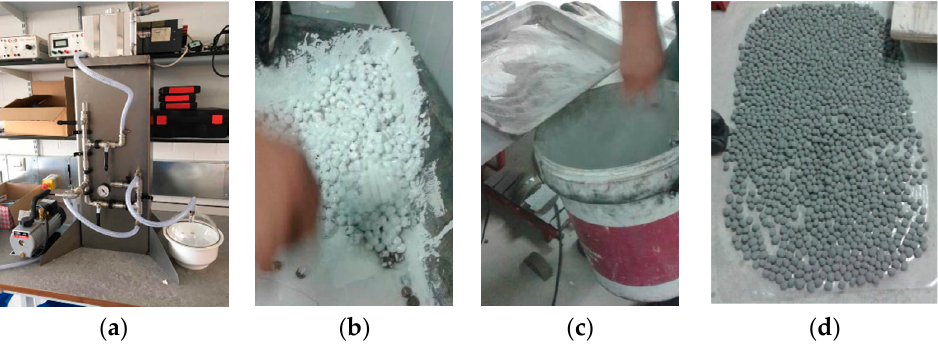
Figure 1. PCM impregnation and coating showing ( a ) the vacuum impregnation system ( b ) resin